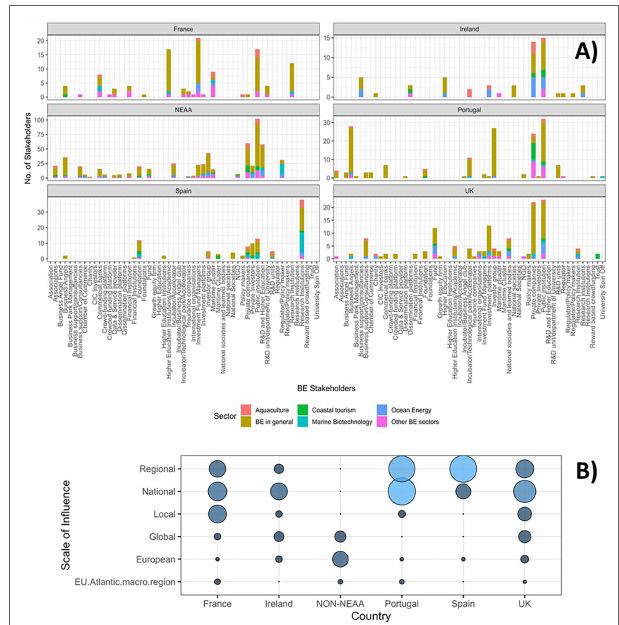
FIGURE 2 | Conceptual framework describing the 3 main steps applied for the analysis of Blue Economy landscape of the